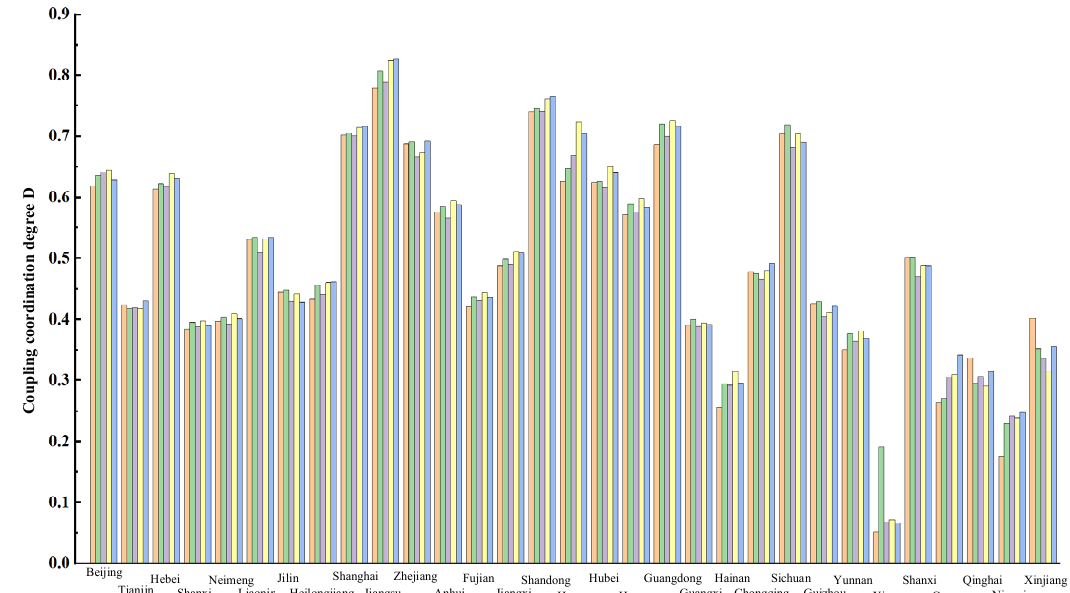
Figure 7. Coupling degree between supply and demand in every region from 2020 to 2024.